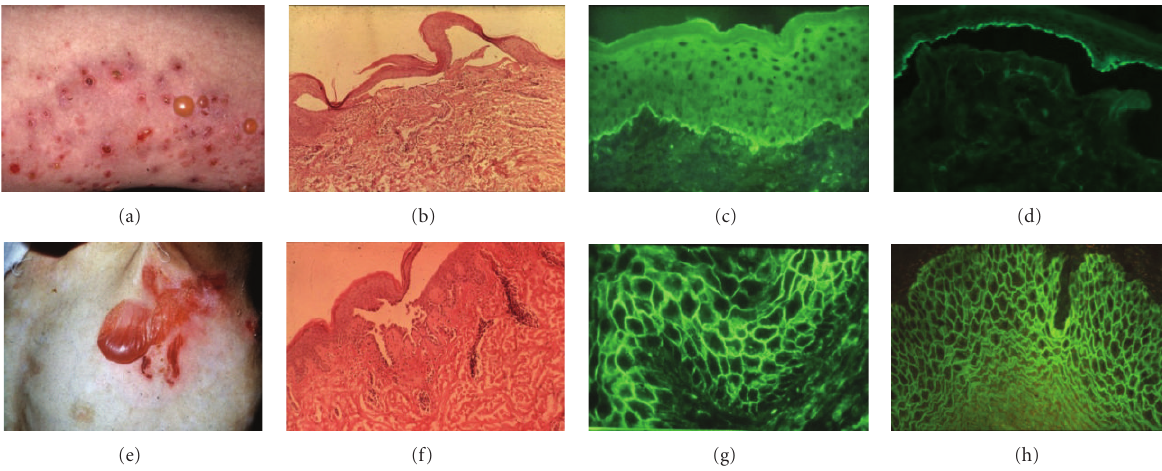
Figure 1: Bullous pemphigoid and pemphigus vulgaris. (a) The clinical picture of generalized pemphigoid with tense blisters, crusts, and erythematous plaques. (b) The histological picture of BP; subepidermal blister. (c) Linear basement zone deposits of IgG in BP. (d) Circulating IgG antibodies bind to the epidermal site of SSS in a patient with BP. (e) The flaccid blister in PV. (f) The histological picture of PV with intraepidermal blister. (g) DIF analysis demonstrates binding of C3 to the intercellular cement substance (ICS) in the upper stratum Malpighii. (h) An IIF study with monkey esophagus as substrate demonstrates the presence of anti-ICS antibody with antihuman IgG